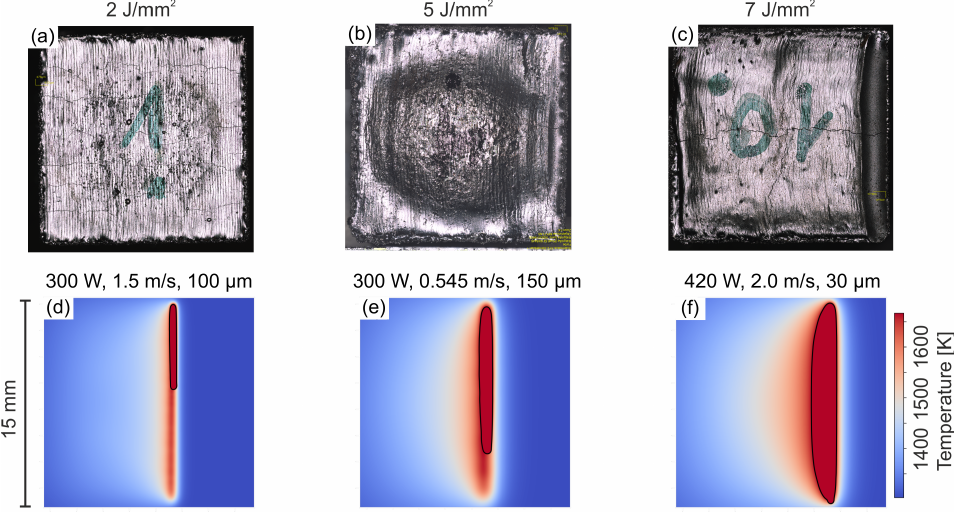
Figure 2. Experimentally observed surfaces ( a – c ) and calculated temperature fields ( d – f ) for parame- ters illustrating the continuous evolution of a trailing melt pool ( a , d ) to a fully persistent melt line ( c , f ). The intermediate condition ( b , e ) presents a persistent melt pool that is locally restricted to the center region. black lines in the temperature fields represent T Liquidus of CMSX-4. Lateral melt direction from left to